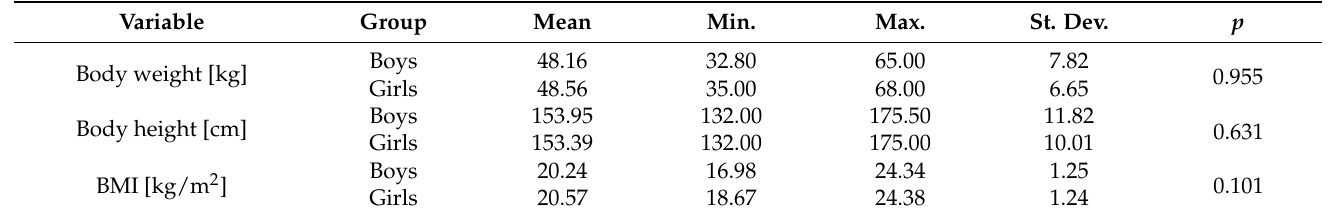
Table 2. Comparison of the physique of girls and boys (differences were considered significant for p < 0.05).